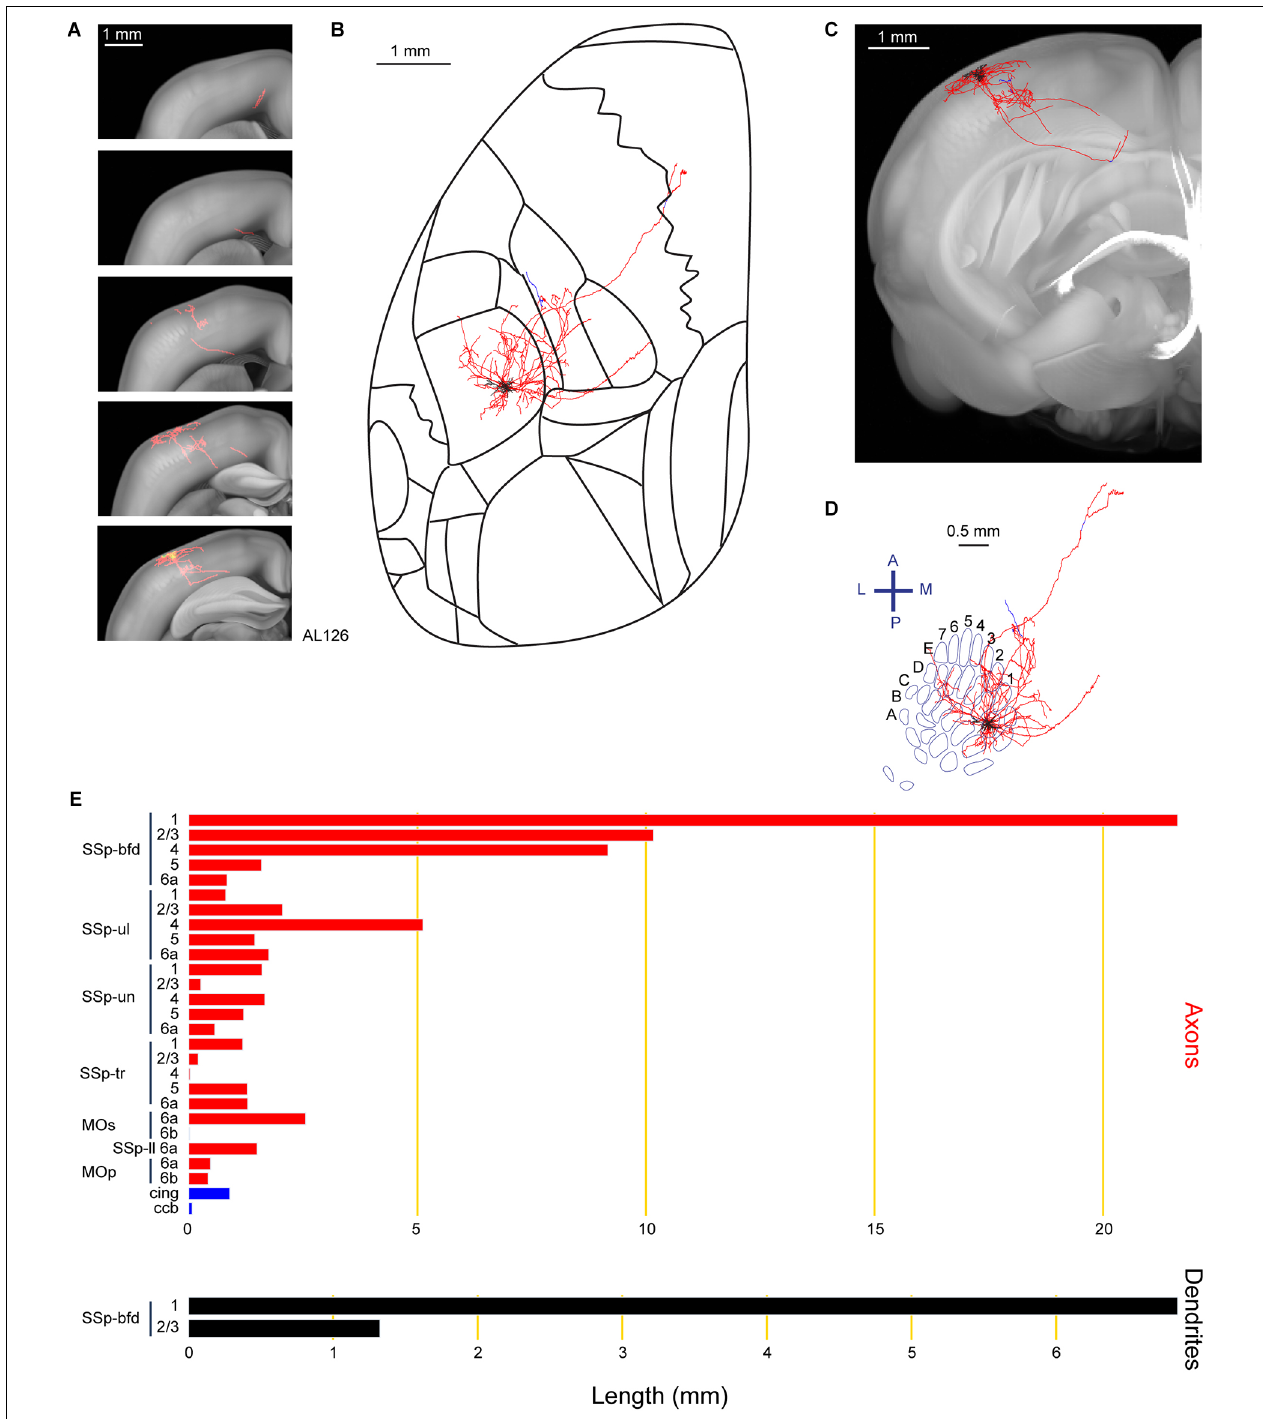
FIGURE 3 | Reconstruction and quantification of example neuron AL126 with projections to the primary and secondary motor cortex. (A) Serial overlays of GFP-labeled axon (red) and dendrites (green) in coronal views encompassing the anterior-posterior span of the axons of 3.5 mm. Each section represents a maximum projection of 700 µ m. (B) Maximum projection of the reconstructed axon and dendrites in horizontal view. (C) Maximum projection of the axon and dendrites in coronal view. (D) Maximum projection of the axon and dendrites in tangential view (rotated 30 degrees) over the barrel field. The neuron is located in the D1 barrel column. (E) Quantification of axonal (top) and dendritic (bottom) length in respective brain regions identified by the Allen Mouse CCFv3. For (B) to (E) : dendrites are shown in black; axon in neocortical gray matter is shown in red; axon in white matter is shown in blue.